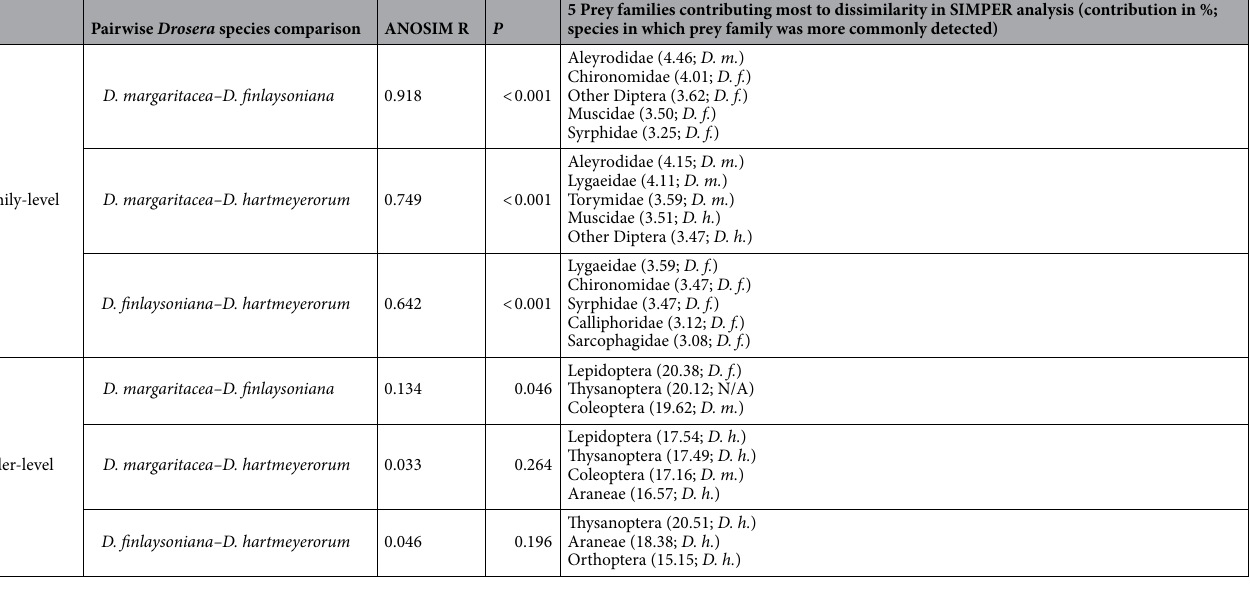
Table 2. DNA metabarcoding detection of family- and order-level prey spectra differences among three species from D. sect. Arachnopus in Western Australia. Prey compositions are compared by Analysis of Similarity (ANOSIM) and Similarity Percentages (SIMPER) for all pairwise comparisons of studied species. D. f. = D. finlaysoniana , D. h. = D. hartmeyerorum , D. m. = D.